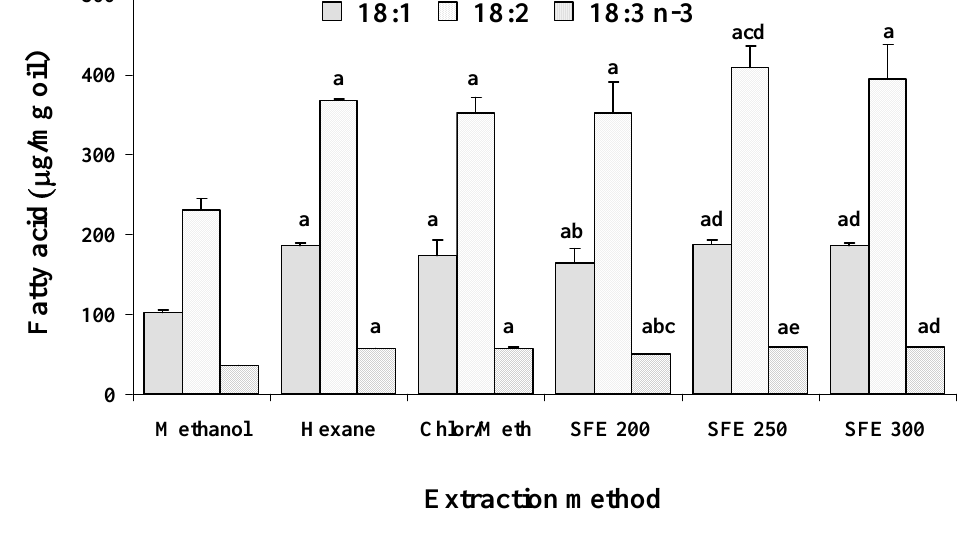
Figure 4. Values (expressed as  g/mg oil) of oleic (18:1), linoleic (18:2), and linolenic (18:3 n-3) acids measured by high-performance liquid chromatography (HPLC-DAD) (200, 250, and 300 bar) and method in wheat germ oil samples obtained by SC-CO 2 organic solvent extraction (hexane, methanol, and chloroform-methanol). p< 0.05, a = versus methanol, b hexane, c chloroform-methanol, d 200 bar, e 250 bar; (n =